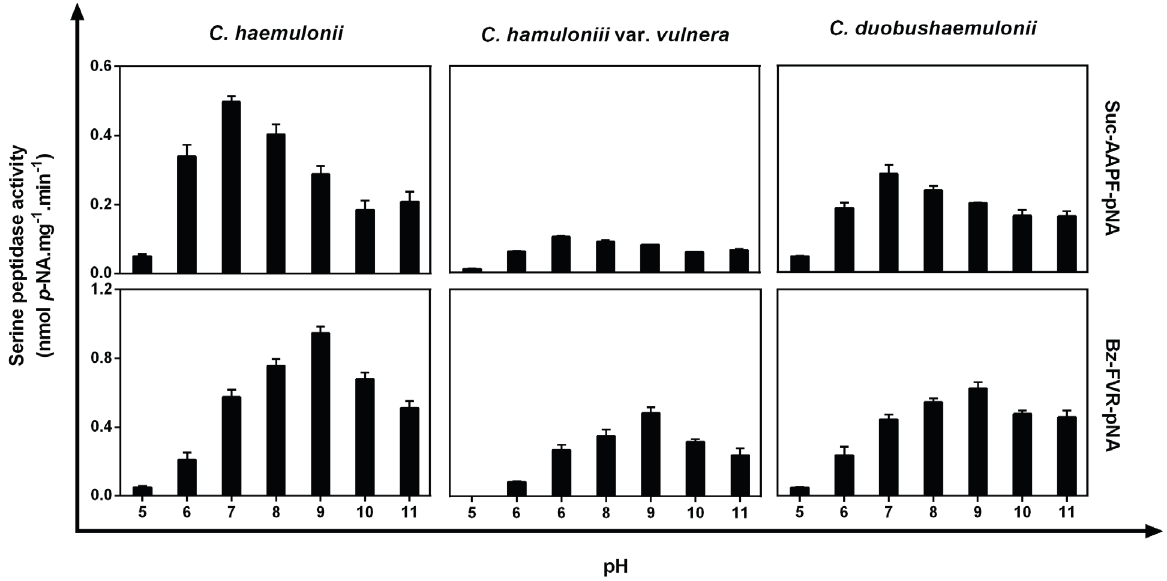
Figure 2 - Effect of pH on chymotrypsin- and trypsin-like activities measured in the culture supernatants of clinical isolates of the C. haemulonii complex. the serine peptidase activities were evaluated by spectrophotometry in a pH range varying from 5.0 to 11.0 for 60 min at 37°C. two substrates were used: N -succinyl-Ala-Ala-Pro-Phe- p Na for chymotrypsin and N -benzoyl-Phe-Val- Arg- p Na for trypsin. the bars represent the mean ± SD from at least three independent experiments.